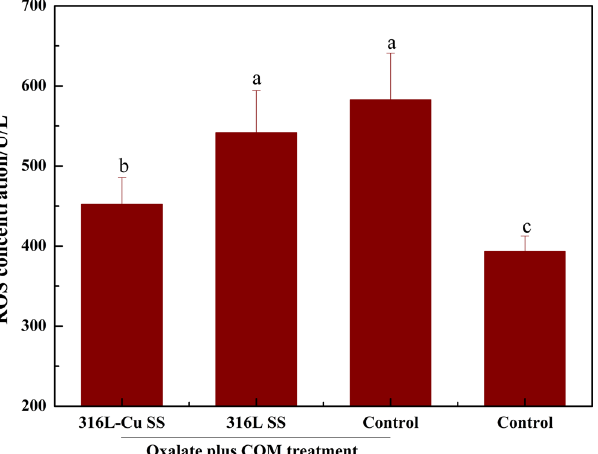
Figure 6. HA secretion into the culture medium after incubating for 24 h. A significant difference at p < 0.05 is shown with different